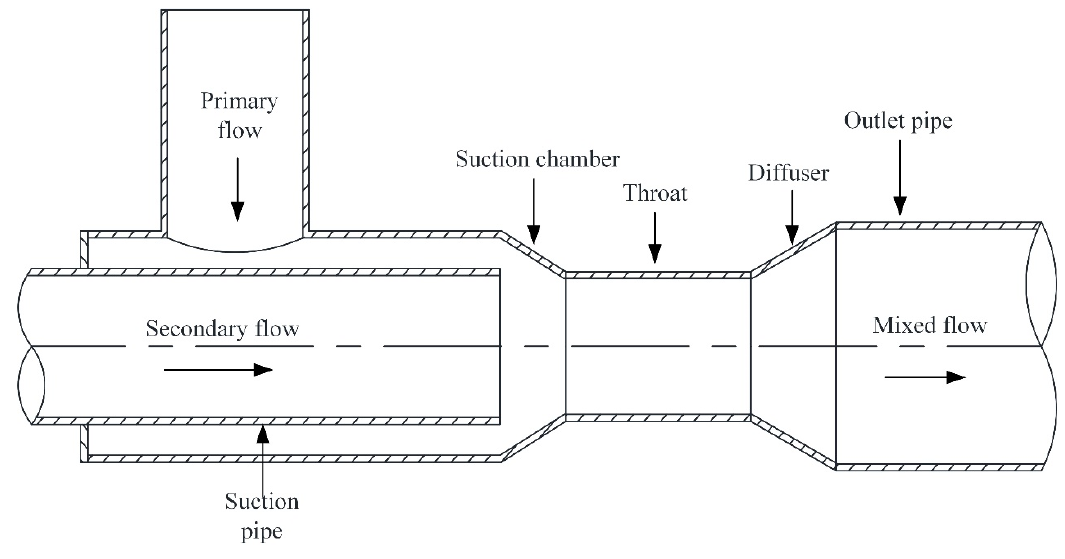
Figure 1. Structural schematic drawing of annular jet pump.